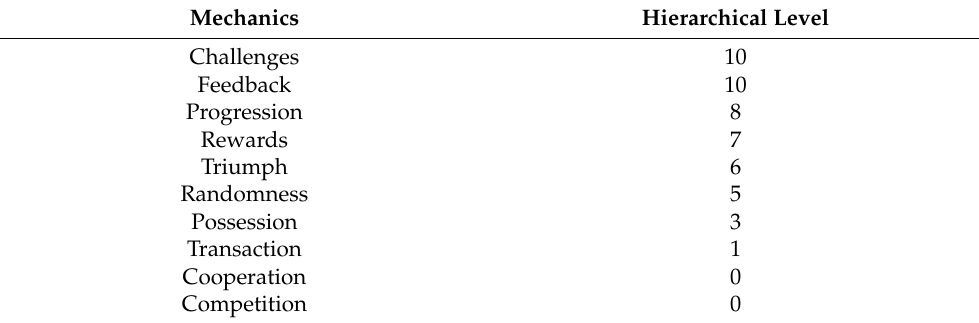
Table 2. Hierarchical order of gamification processes directed towards game mechanics.